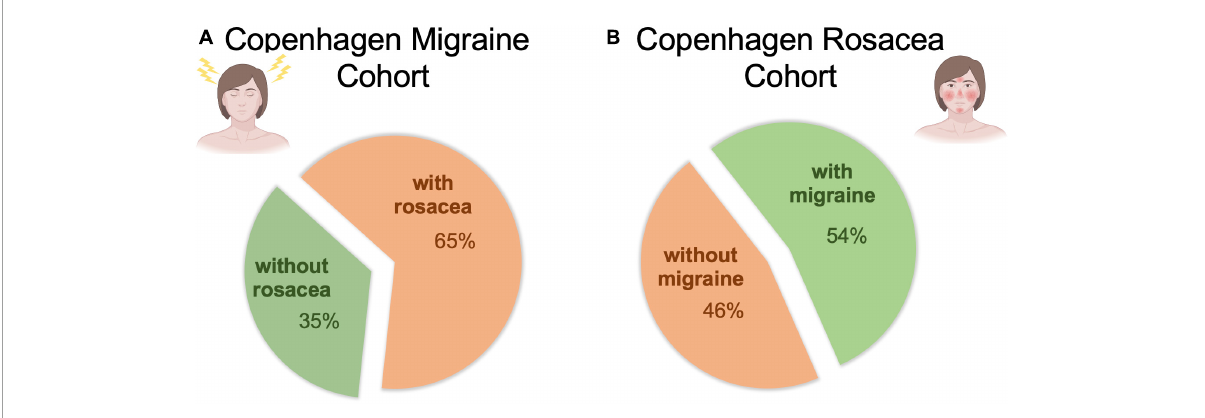
FIGURE1 Prevalence of rosacea and migraine in each cohort. (A) Prevalence of rosacea in COMICO. (B) Prevalence of migraine in COROCO. COMICO, Copenhagen Migraine Cohort; COROCO, Copenhagen Rosacea Cohort.